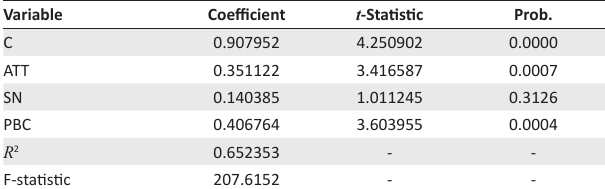
TABLE 8: Two-stage least squares – Regression analysis with Bartlett-Kernel, Newey-West adjustments for heteroskedasticity (Dependent Variable: Intentions). Variable Coefficient t -Statistic Prob. C